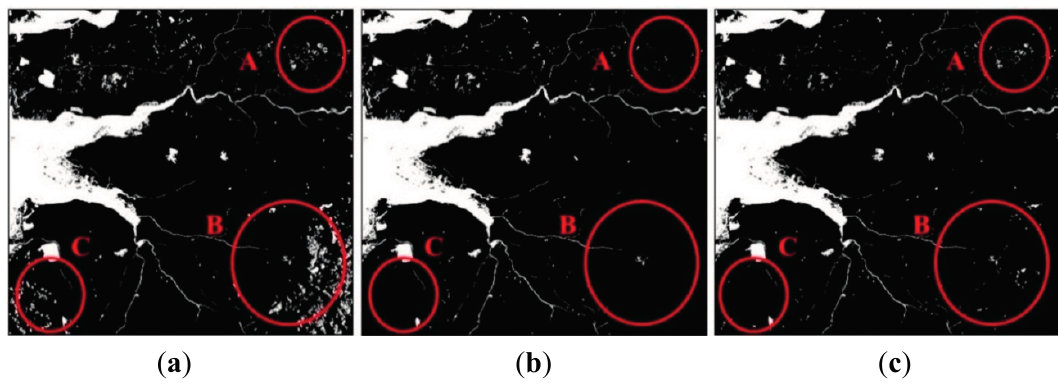
Figure 8. The water classification results of: ( a ) Case #4; ( b ) Case #5; ( c ) Case